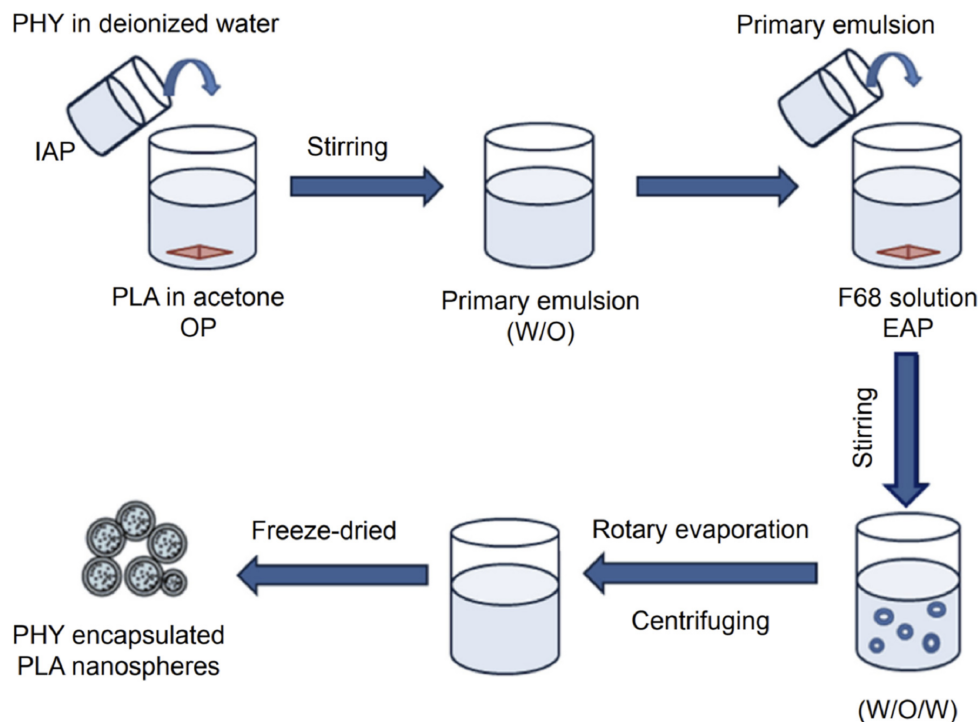
Figure 5. Schematic illustration of the fabrication process of PHYP and empty PLA nanospheres. Note: The formulations were prepared by the double emulsion solvent evaporation method and stored at 4 ◦ C prior to usage. Abbreviations: PHYP, pachyman-loaded poly(d,l-lactic acid); PLA, polylactide; PHY, pachyman; IAP, internal aqueous phase; OP, organic phase; EAP, external aqueous phase; w/o, water in oil; w/o/w, water in oil in water. (Adapted from